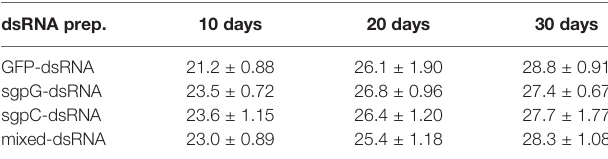
TABLE 1 | Average body weight of treated shrimps (g, mean ± SEM, n = 6) at 0, 10, 20, and 30 days after treatment with each dsRNA preparation. dsRNA